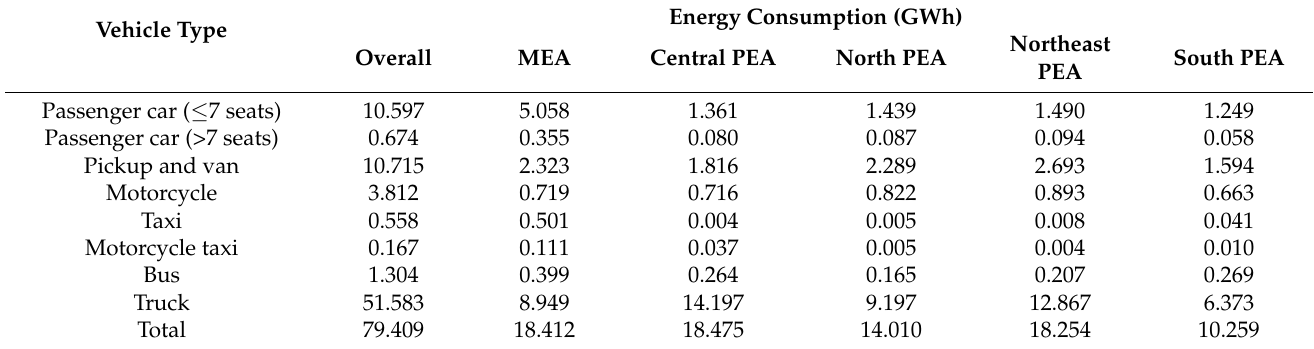
Table 3. Energy consumption for each vehicle